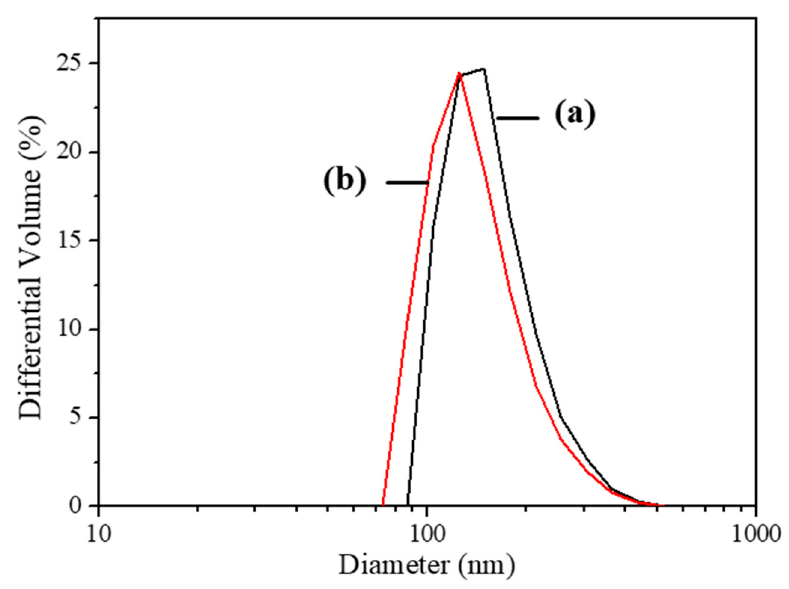
Figure 2. Median particle size (D 50 ) of Y 2 O 3 :Eu 3+ nanosol dispersed in ( a ) ethanol and ( b ) H 2 O as solvent.